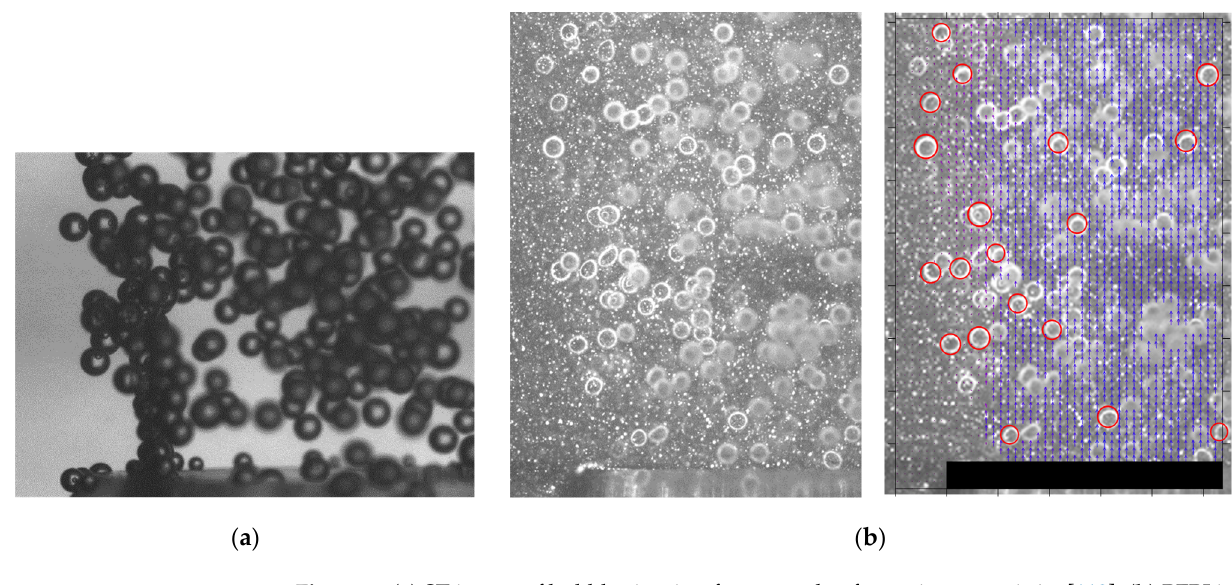
Figure 8. ( a ) ST image of bubbles issuing from nozzle of an axisymmetric jet [119]; ( b ) BFBI image and the result of processing for the same flow [119].